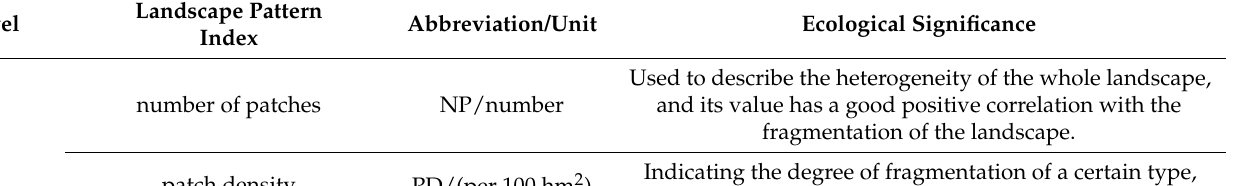
Table 3. Description of landscape pattern